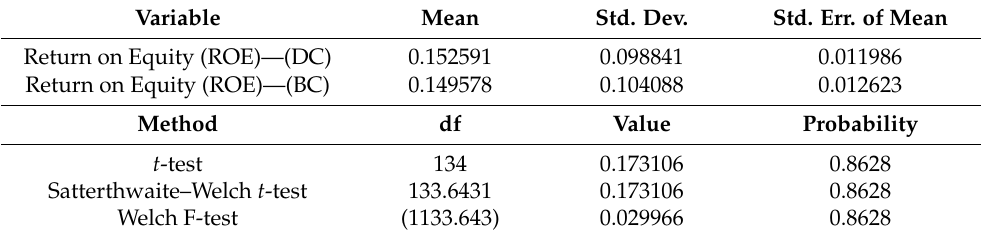
Table 3. The result of ROE.